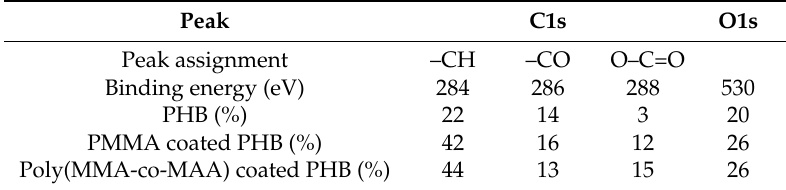
Table 2. Surface concentration (%) investigation by XPS on coated and uncoated electrospun PHB fibers. Peak C1s O1s Peak assignment